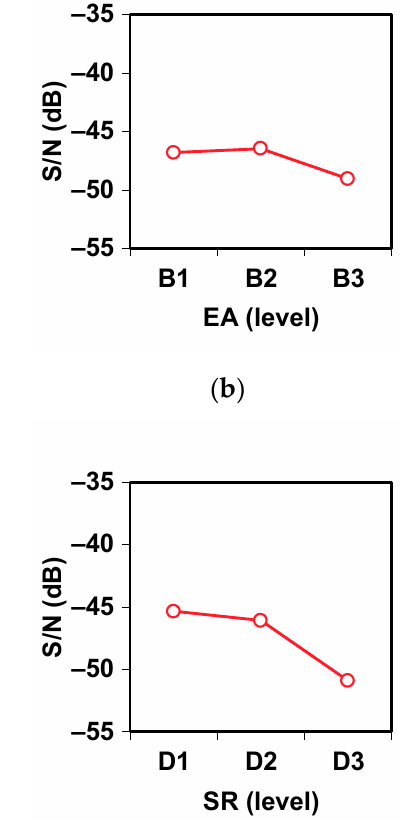
11 Table 4. Mean values of S/N index and maximum differences between levels on CO. P